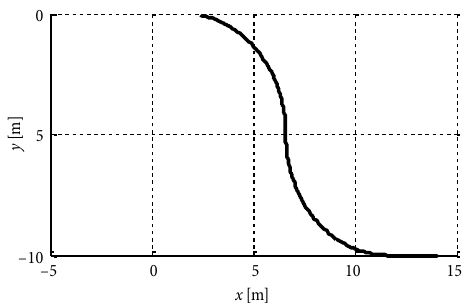
Fig. 8. Typical simulation axis of the track center line consisting of two semicircles, for the value of the turn radius R = 5 m